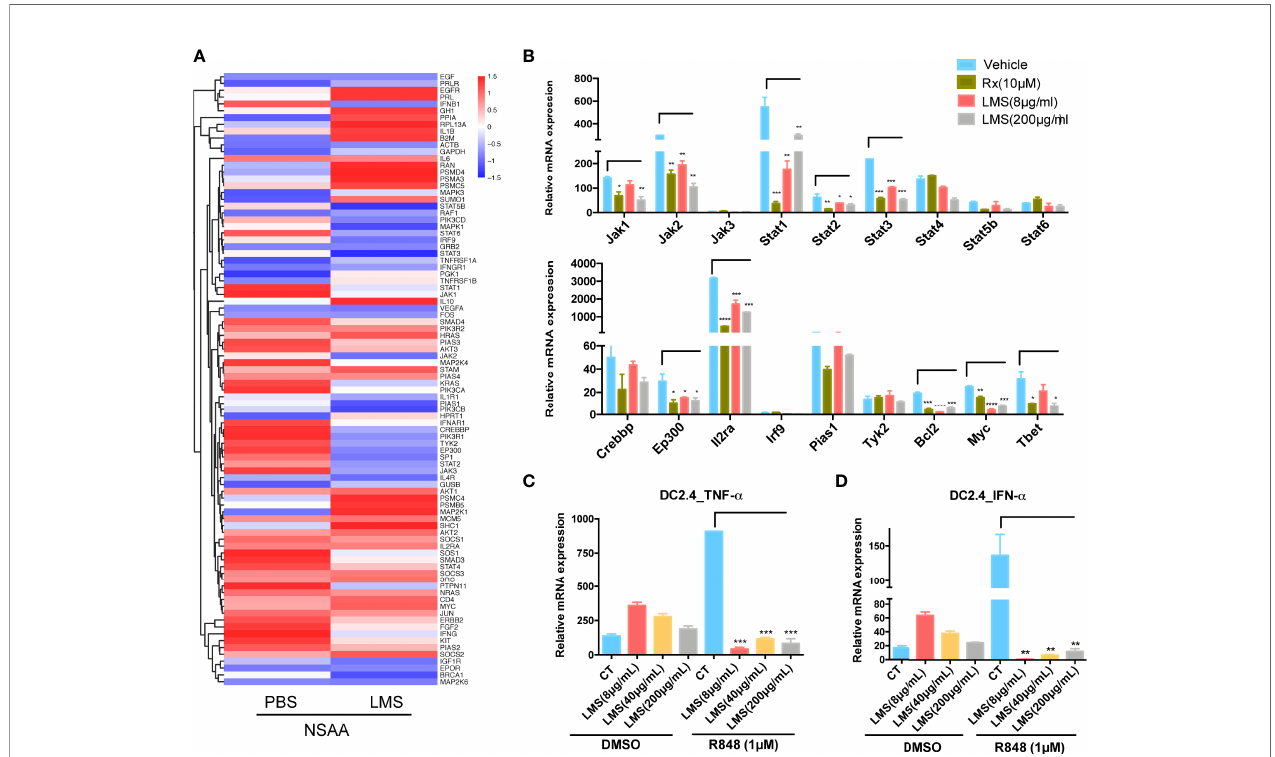
FIGURE 6 | LMS downregulated key molecules related to TLR and JAK/STAT signaling pathways directly in vitro . (A) Heatmaps showed the TLR and JAK/STAT signaling pathway-related genes differentially expressing based on their function in NSAA patients treated with PBS or 40 m g/ml LMS for 48 h in vitro according to RNA sequencing (PBS: n = 2; LMS: n = 2); (B) In vitro puri fi ed naive CD4 + T cells from wild-type C57BL/6 mice were treated with or without different doses of LMS (8 m g/ml, 200 m g/ml) or 10 m M ruxolitinib (Rx) under the Th1 polarization conditions [anti-CD3/28 antibodies (4 m g/ml), anti-IL-4 antibodies (10 m g/ml), and IL-12 (10 ng/ml)] for 4 days. The mRNA expression of molecules related to the JAK/STAT signaling pathway in these cells was detected by RT-PCR ( n = 3). (C, D) The mRNA expression of IFN- a and TNF- a was shown in DC2.4 cells with or without different doses of LMS (8 m g/ml, 40 m g/ml, and 200 m g/ml) under 1 m M R848 stimulation in vitro for 48 h by RT-PCR ( n = 3). * p < 0.05; ** p < 0.01; *** p < 0.001, **** p < 0.0001. All data represent at least three independent